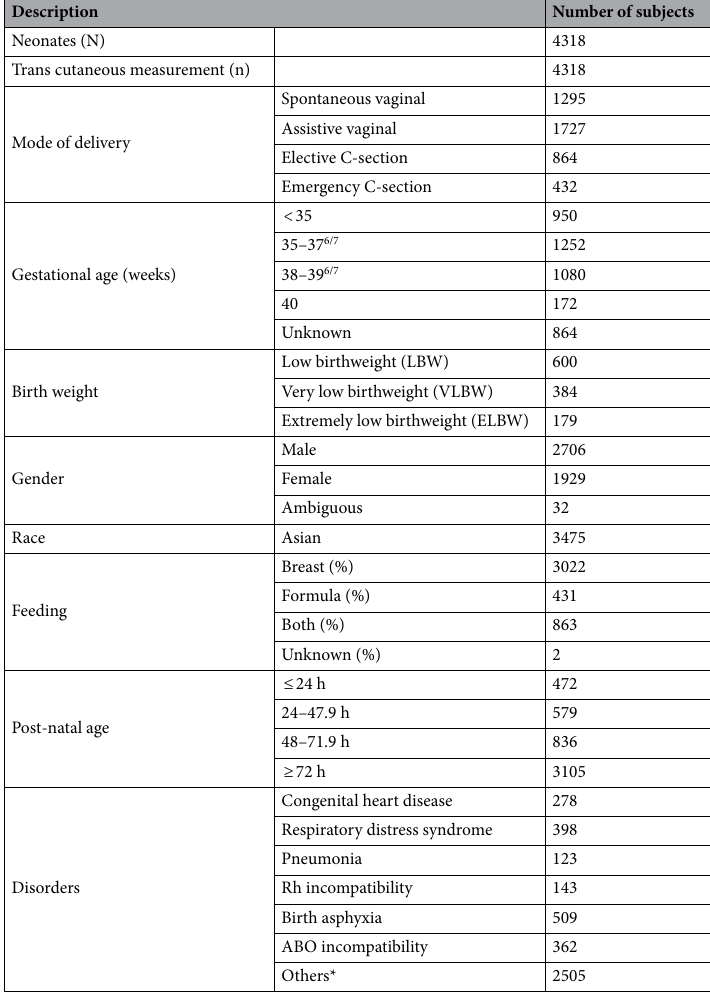
Table 2. Demographic details of the neonates participated in the study. *Other disorders include hypoglycemia, sepsis, infant of diabetic mother, jitteriness, premature rupture of the membranes (PROM), apnoea of prematurity, maternal varicella, intra uterine growth retarded (IUGR), hepatosplenomegaly, torch (+ ve, HSV, CMV), congenital rubella (IgM + ve), hypothyroid, osteogenesis imperfect, meningitis, Pierre Robin Syndrome and